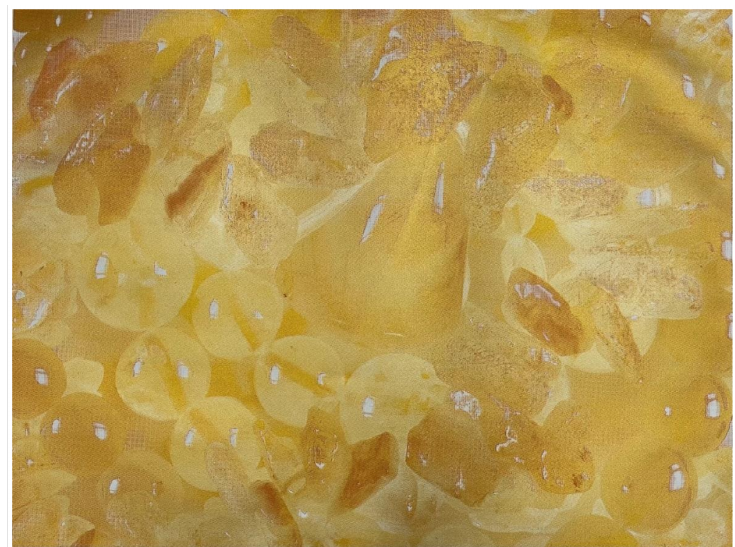
Figure A14. 25LPI, screen-print, 55H mesh, Y = Pyrisma™ Ambercup Orange, M = Iriodin™ Solar Gold, B = Iriodin™ Platinum Gold, C = Iriodin™ Icy White, printed dark to light, white Plike, film positive, print size: 600 mm × 450 mm.